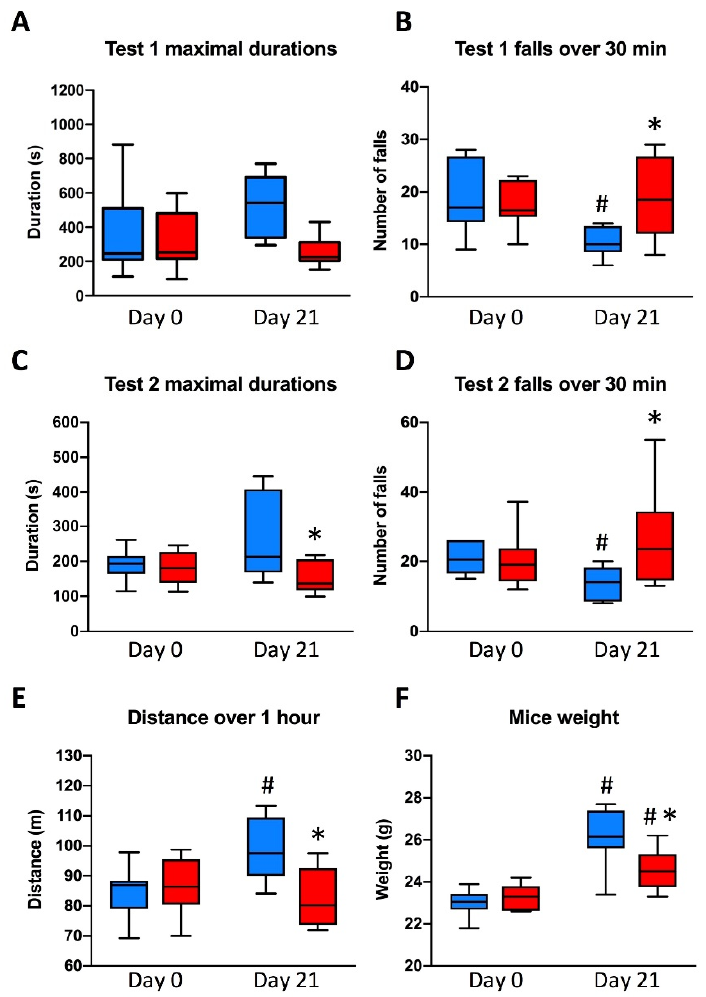
Figure 2. Endurance measured on Rotarod and mice body weights. ( A ) Maximal durations and ( B ) number of falls in test 1 (speed of 10 to 20 rpm for 180 s followed by a constant speed of 20 rpm), ( C ) maximal durations and ( D ) number of falls in test 2 (speed of 10 to 30 rpm for 180 s followed by a constant speed of 30 rpm), ( E ) distance over 1 h performed by mice, and ( F ) weight of mice. C (blue boxes), control group; ID (red boxes), ID group; N = 8 in each group. Box-plots represent medians, interquartile ranges and upper and lower values according to Tukey’s method. * p < 0.05 compared with control group on the same day; # p < 0.05 compared with the same group on Day 0.